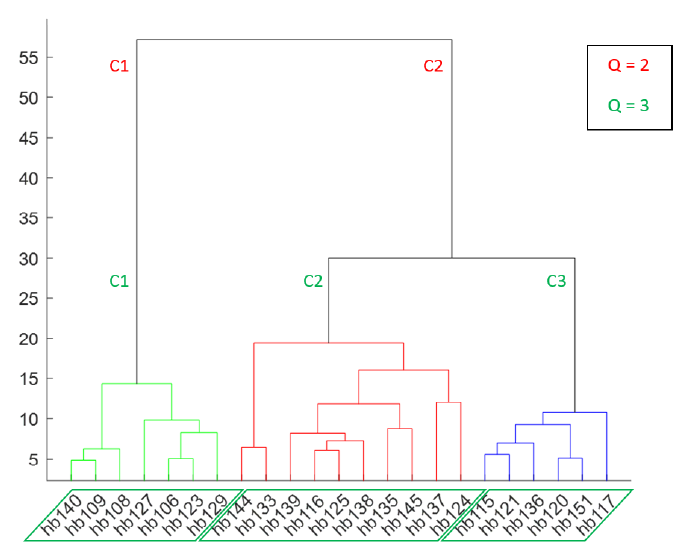
Figure 16. Dendrogram of the agglomerative hierarchical clustering for urban environment at the weekend. Clustering solutions for Q = 2 (in red) and Q = 3 (in green) are also highlighted.